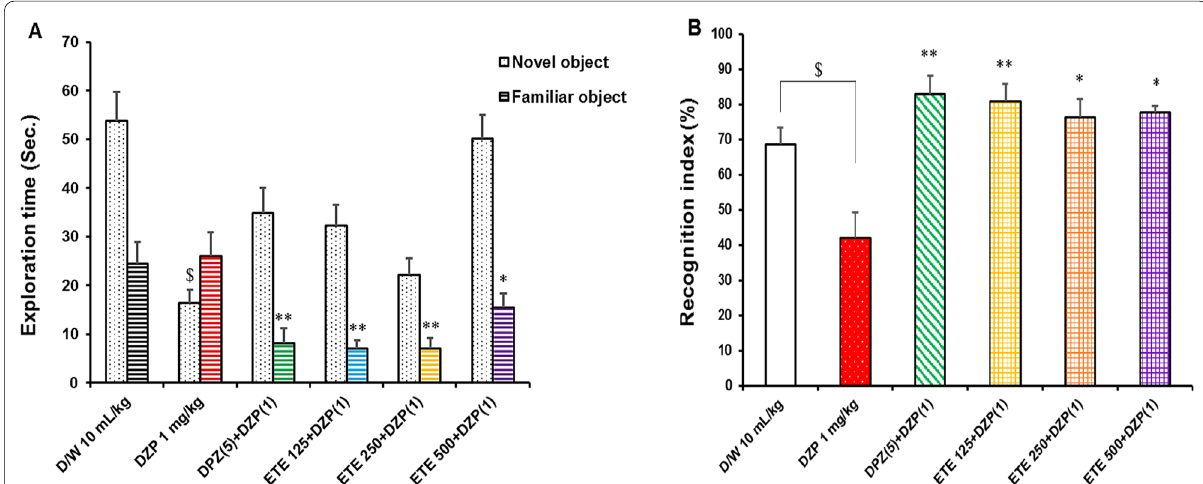
Fig. 4 Effect of Eragrostis tremula extract on object recognition following diazepam-induced amnesia in mice. A Recognition index. Values are mean one-way ANOVA followed by Bonferroni’s test, n